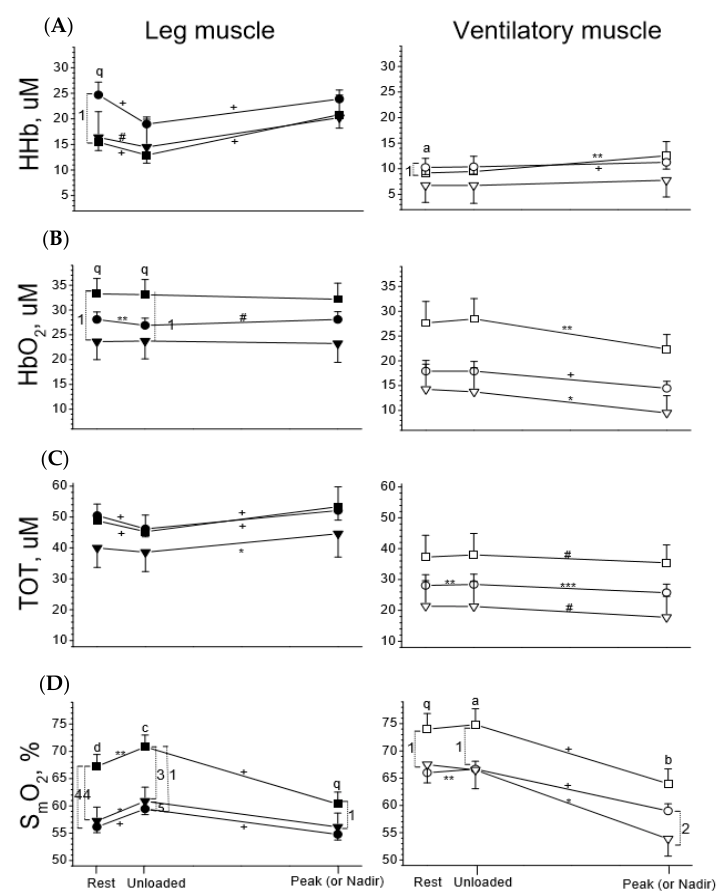
Figure 3. Tissue deoxygenation (HHb, row ( A )), oxygenation (HbO 2 , row ( B )), total blood capacity (TOT, row ( C )), and saturation (S m O 2 , row ( D )) of leg muscles (left panels, solid symbols) and ventilatory muscles (right panels, open symbols) in response to incremental exercise in healthy subjects (square symbol) and subjects with chronic obstructive pulmonary disease (COPD, circle symbol) and congestive heart failure (CHF, down triangle symbol). ANOVA was used for group comparisons at 3 stages of exercise, respectively: q p < 0.1, a p < 0.05, b p < 0.01, c p < 0.001, d p < 0.0001; Paired t tests were used for comparisons of changes in variables between rest and unloaded exercise and between unloaded exercise and at peak (or nadir) exercise, respectively: # p < 0.1, * p < 0.05, ** p < 0.01, *** p < 0.001, + p < 0.0001. Comparisons of variables between two groups of subjects, Arabic numbers 5 p < 0.1, 1 p < 0.05, 2 p < 0.01, 3 p < 0.001, 4 p < 0.0001.